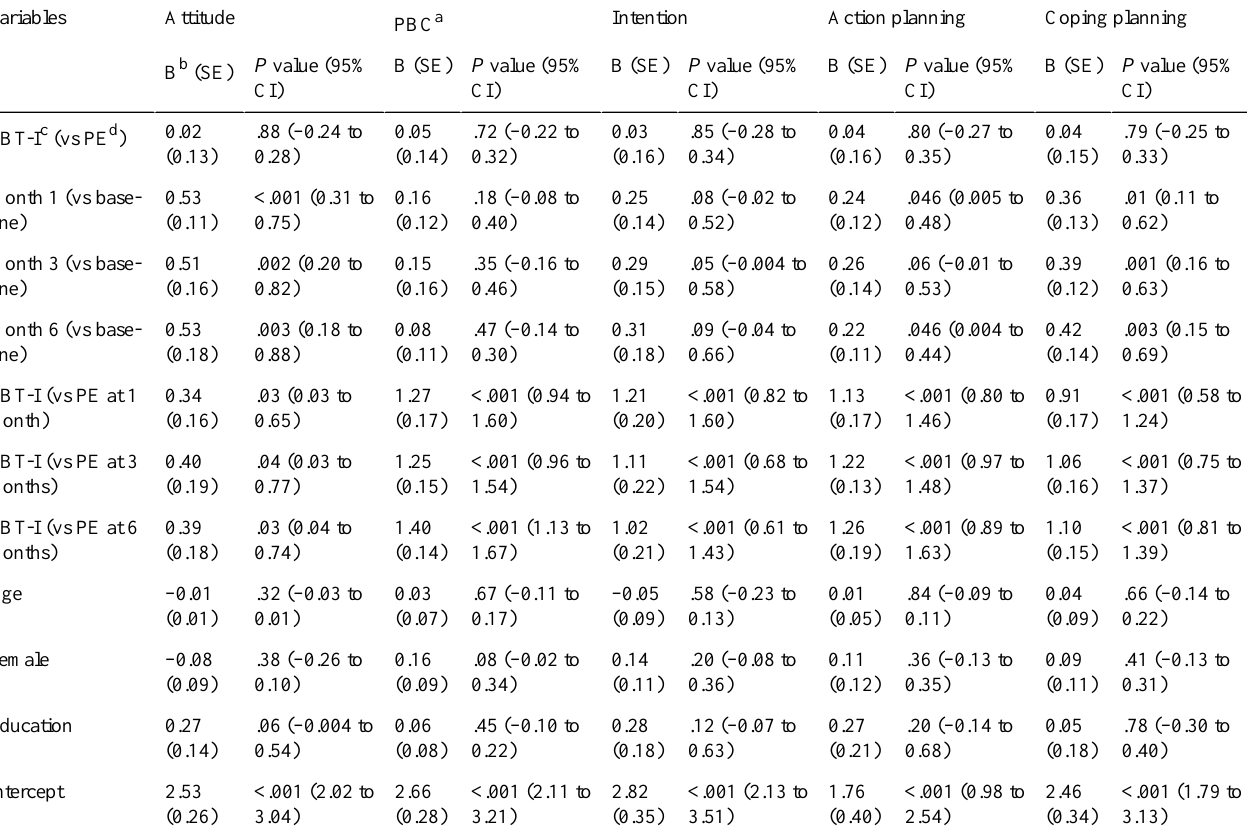
Table 5. Results of the linear mixed models for measures on theory of planned behavior and health action process approach concepts.